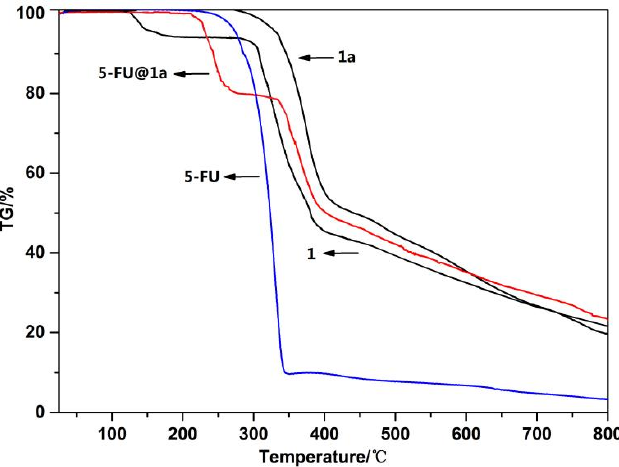
Figure 3. IR spectra of complex 1 , complex 1a , 5-FU@ 1a , and 5-FU.